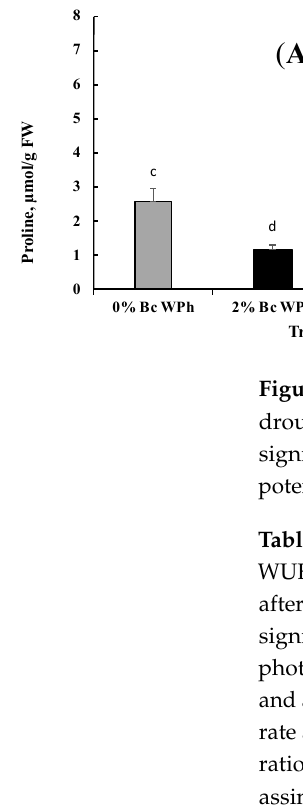
Table 2. CO 2 /H 2 O gas exchange and chlorophyll fluorescence parameters (A net , V c , SC, C i /C a ratio, WUE, R L , R D , ETR, ETR/A gross and Y(NPQ)) of Medicago ciliaris leaves at a saturating light intensity after 3 weeks of drought treatment. Values represent mean  SE ( n = 5) and different letters indicate significant differences between treatments. Net CO 2 assimilation rate (A net ) [μmol(CO 2 ) m –2 s –1 ], pho- tosynthetic efficiency (V c ), stomatal conductance (S c ) [mol(H 2 O) m –2 s –1 ], ratio of intercellular and